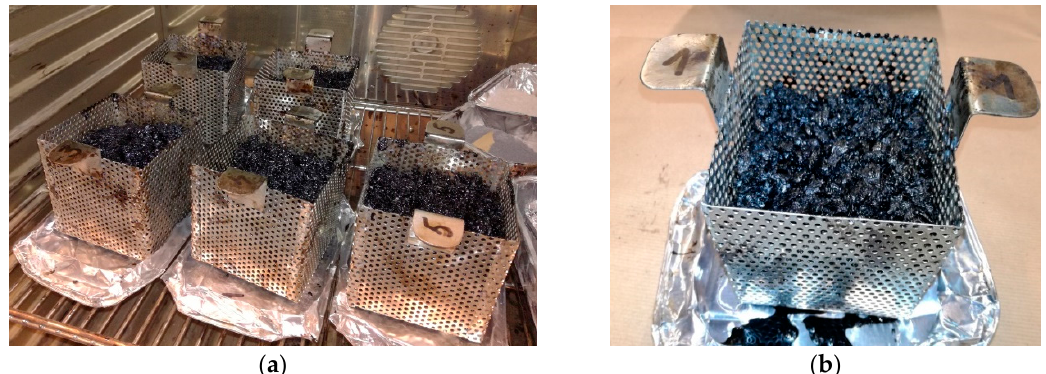
Figure 14. The drainage test: ( a ) asphalt mixes with peat and ( b ) the REF asphalt mix [24].